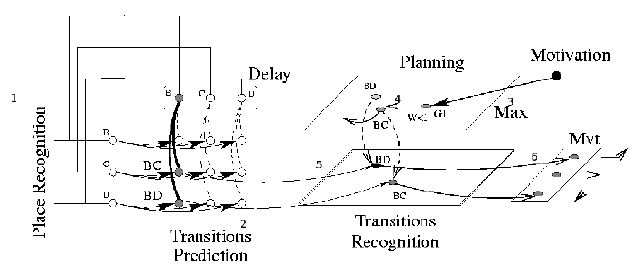
Figure 5. Simplified view of a cognitive map based on transition cells. The moti- vation system modulates the activity of neurons at the planning